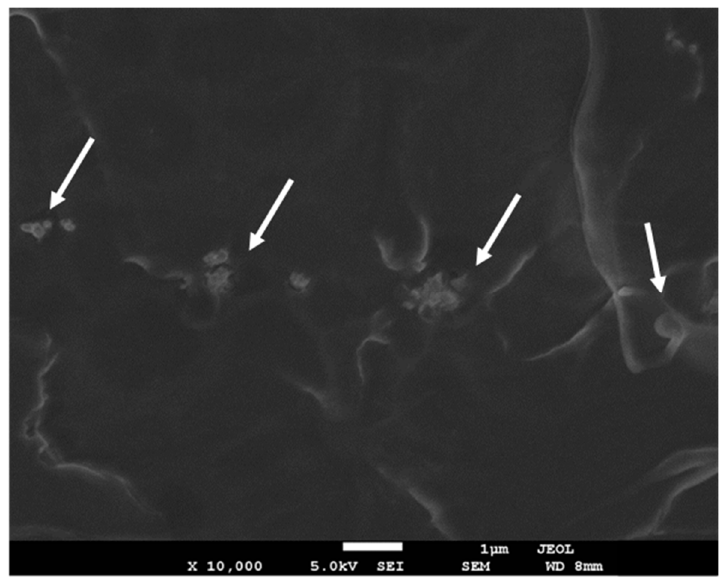
Figure 2. High-resolution SEM micrograph for PLLA/IF-WS 2 (1.0 wt%) nanocomposites. The white arrows indicate the IF-WS 2 .